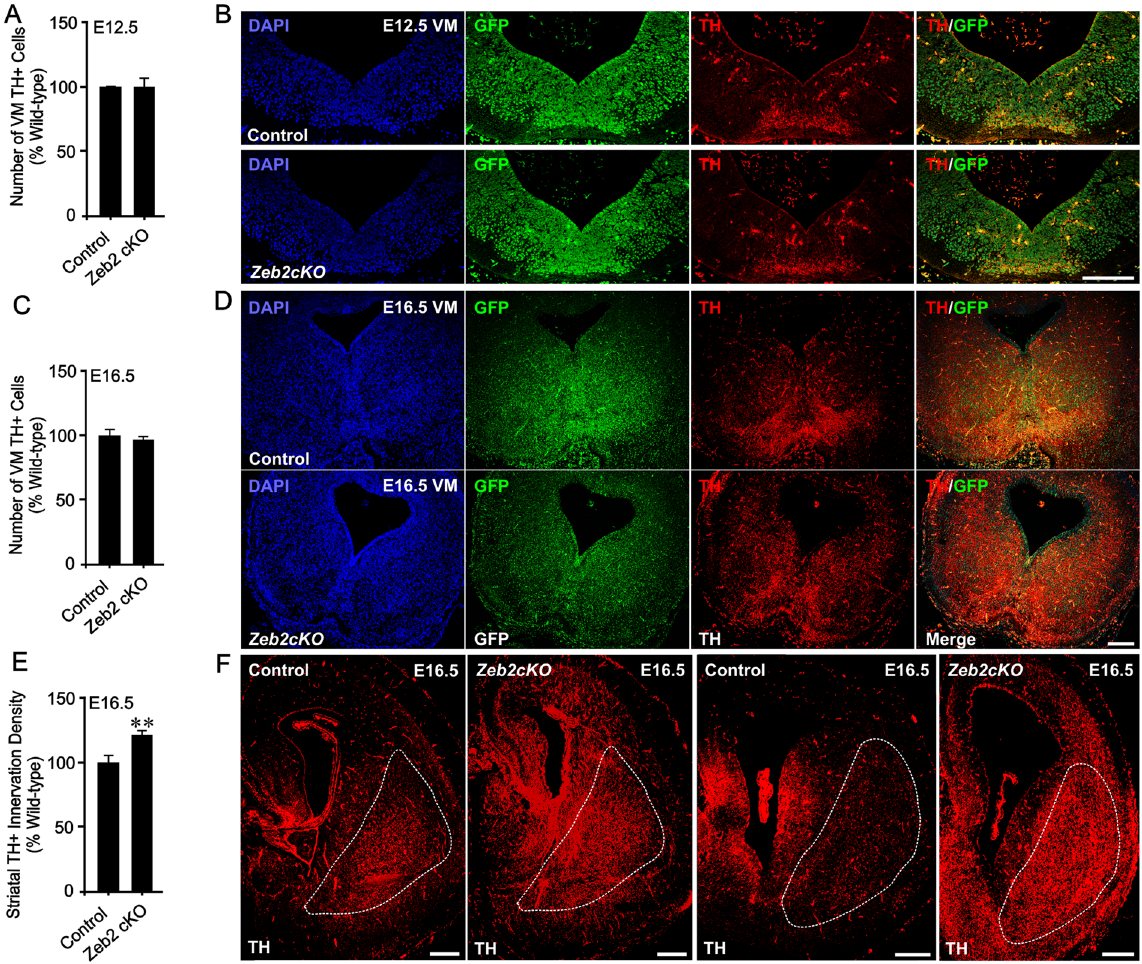
Figure 4. Zeb2-deficient mice have dopaminergic hyperinnervation of the striatum. ( A , C ) Graph of mDA neuron number in Zeb2 cKO mice and mice expressing normal levels of Zeb2 (control) at ( A ) E12.5 and ( C ) E16.5. ( B , D ) Representative sections of the midbrain Zeb2 cKO and control mice at ( B ) E12.5 and ( D ) E16.5 showing DAPI (blue), GFP (green) and TH (red). ( E ) Graph of TH + striatal innervation density at E16.5 in Zeb2 cKO and Control mice. ( F ) Representative TH-stained coronal sections through the striatum of Zeb2 cKO and control mice at E16.5. The representative serial sections were taken at positions 160 µ m and 280 µ m through the striatum respectively (left hemispheres shown). (n = 5; ** p < 0.01 vs. control; t-test). All data are the mean + SEM. Scale bar = 100 µ